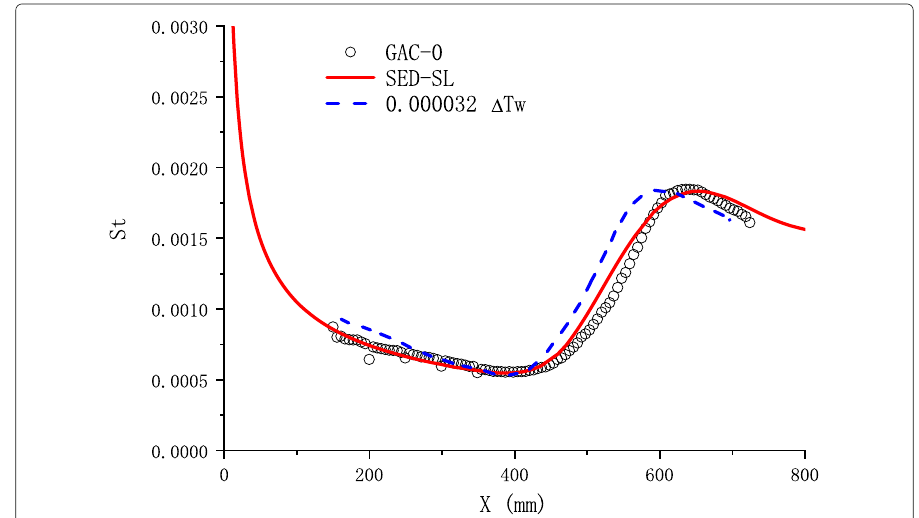
Fig. 2 The St distribution along the meridian line computed by the SED-SL model for the GAC-0 case, compared with the measured St distribution and the measured surface temperature increment with appropriate normalization to collapse in the laminar